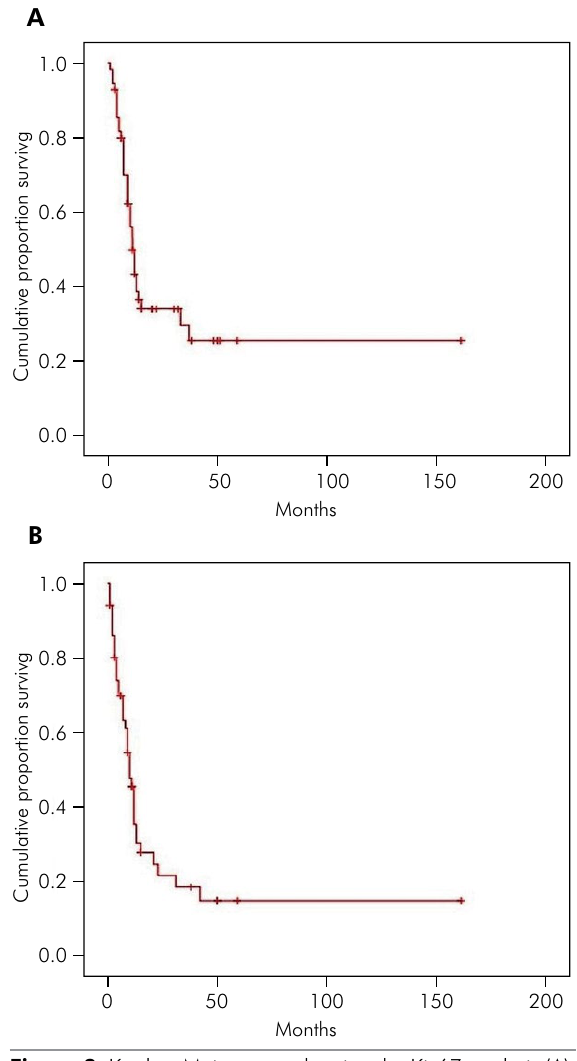
Figure 3. Kaplan-Meier curve showing the Ki-67 analysis (A). Kaplan-Meier curve showing the MCM3 results